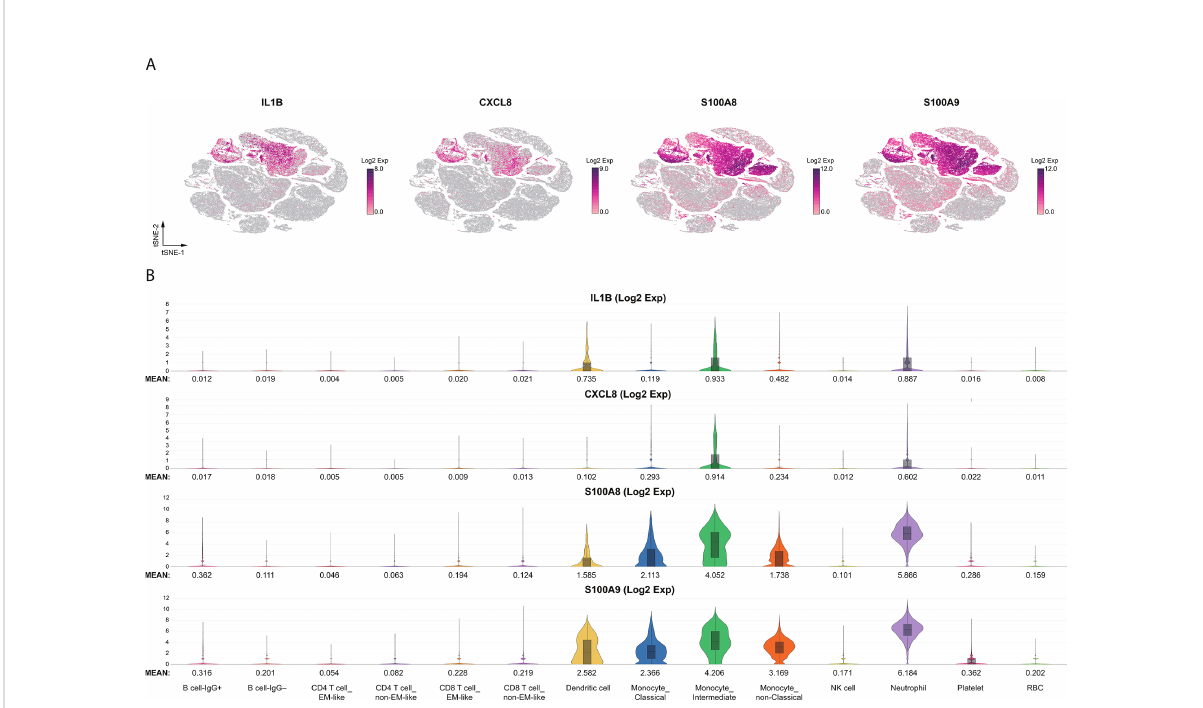
FIGURE 2 Immune landscape of the comparable myeloid in fl ammatory markers. The comparable innate in fl ammatory response between KD and severe COVID-19 with elevated myeloid IL1B, CXCL8, and alarmins of the S100A family were heightened in neutrophils. (A) t-SNE projection of representative gene expression patterns for IL1B, CXCL8, S100A8, and S100A9. (B) Violin plots of normalized log2 expression of the selected activation genes across the 14 different cell